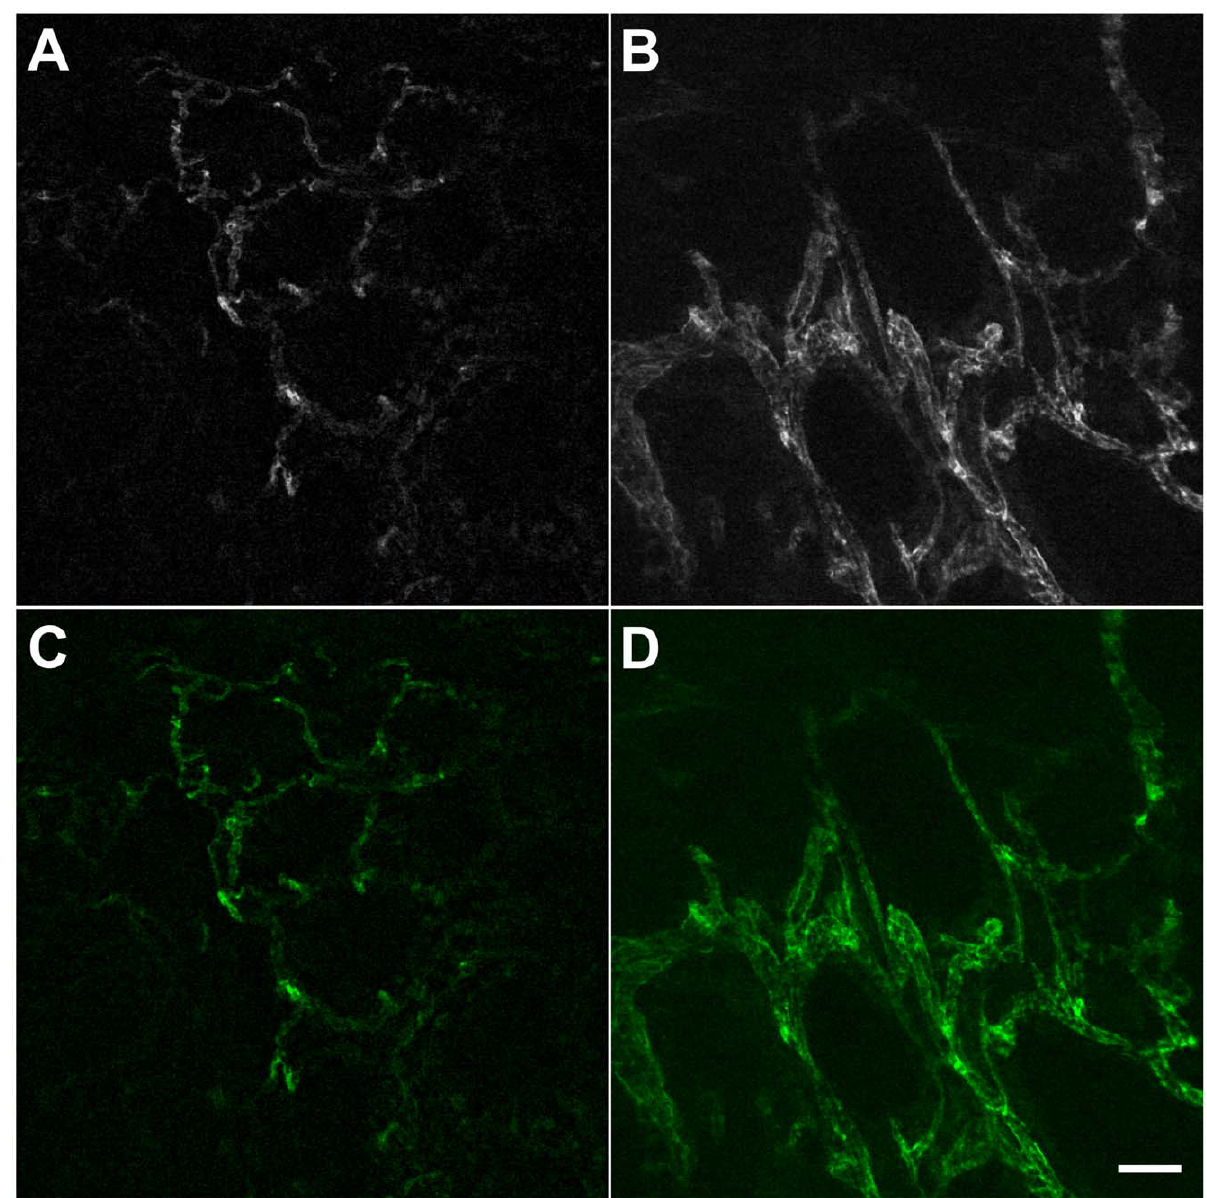
Figure 1. Ex-vivo CLE imaging with AF488-anti-CD31-antibodies. In the normal mucosa, the vessels are organized in a hexagonal network (A); the corresponding area in the tumor shows more dilated, irregularly shaped vessels, with varying diameters along their length (B); the same optical sections are shown with added color overlay (C, D). *Scale bar is 50 m m.